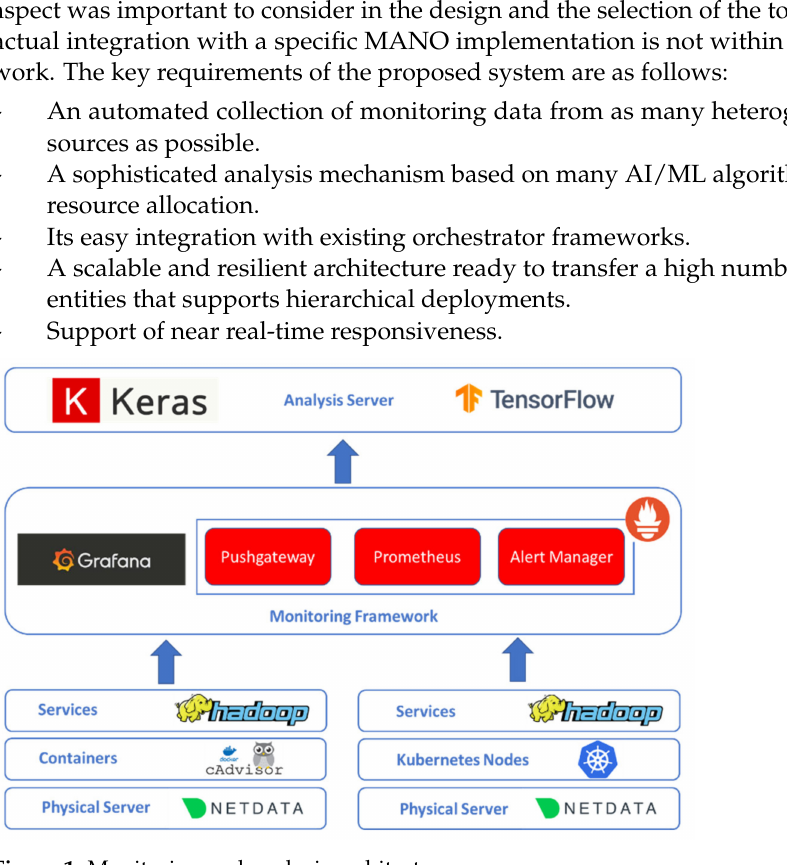
Figure 1. Monitoring and analysis